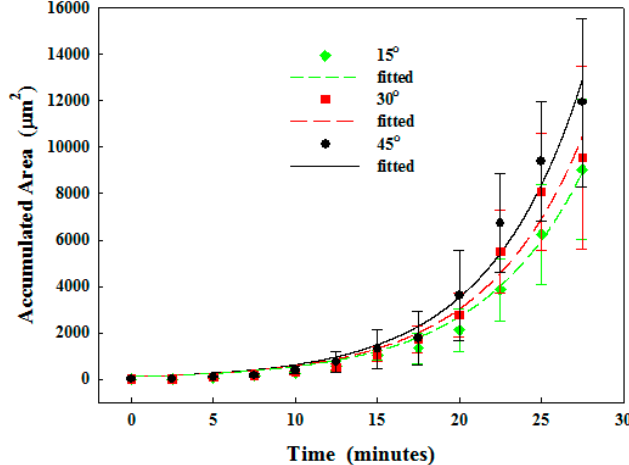
Figure 7. Time-dependent accumulation area of particles in the microchannel at a constriction angle of 15°, 30°, and 45°, and 1% microparticle concentration in deionized water. Table 2. Time-dependent accumulation area in the microchannel with 1% microparticle concentration in alginate solution fitted by Ae Bt and the accumulation area at 25 min of